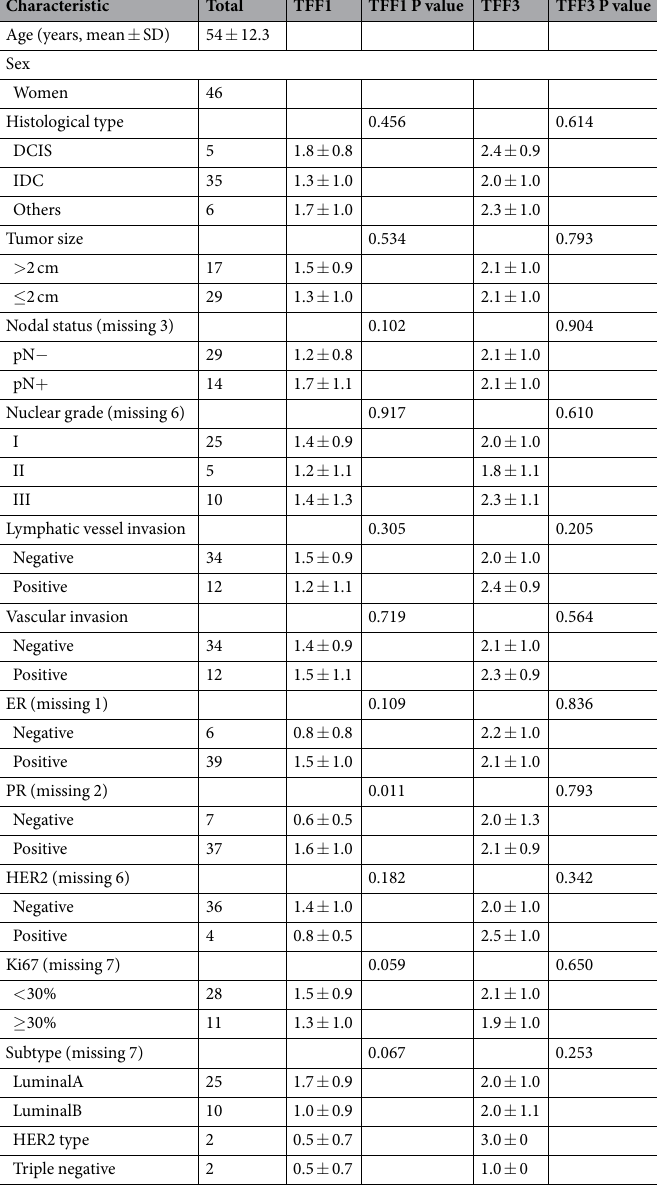
Table 2. Clinicopathological status of breast cancer and immunohistochemical staining (IHC). TFF1 expression was significantly correlated with PR expression only, however, TFF3 expression was not related to any clinicopahological characteristics. SD: Standard Deviation, IDC: Invasive Ductal